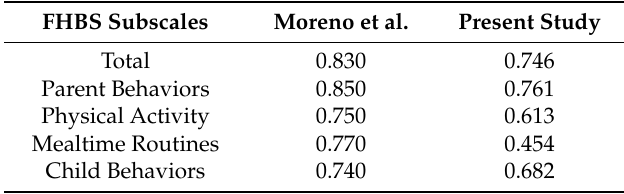
Table 2. Comparison of internal consistency ( α ) in the present study and Moreno et al.